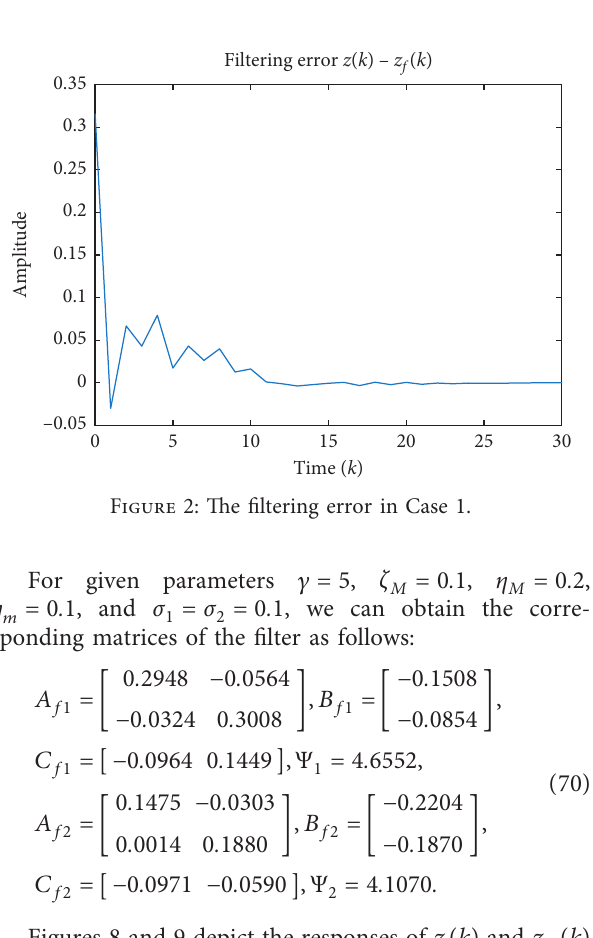
Figure 5: z ( k ) and z